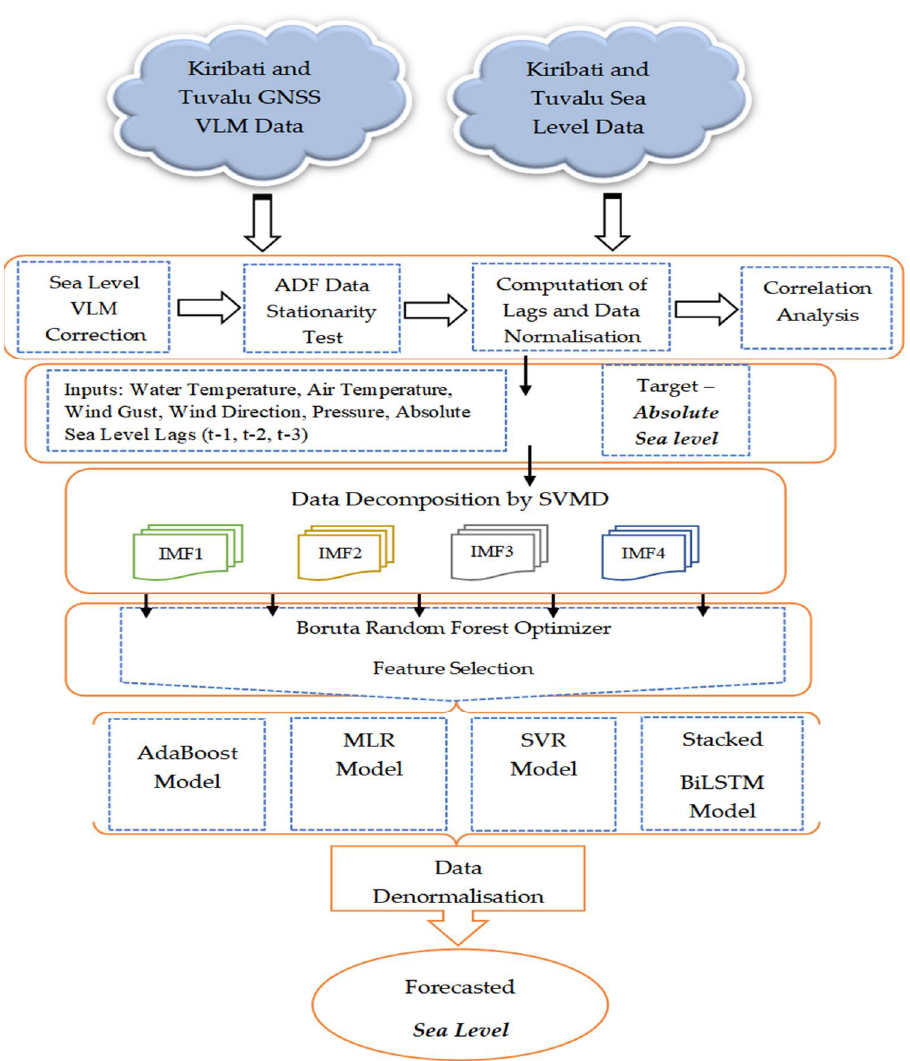
Figure 10. Schematic flow chart view of the sea level forecasting using AI for Kiribati and Tuvalu.